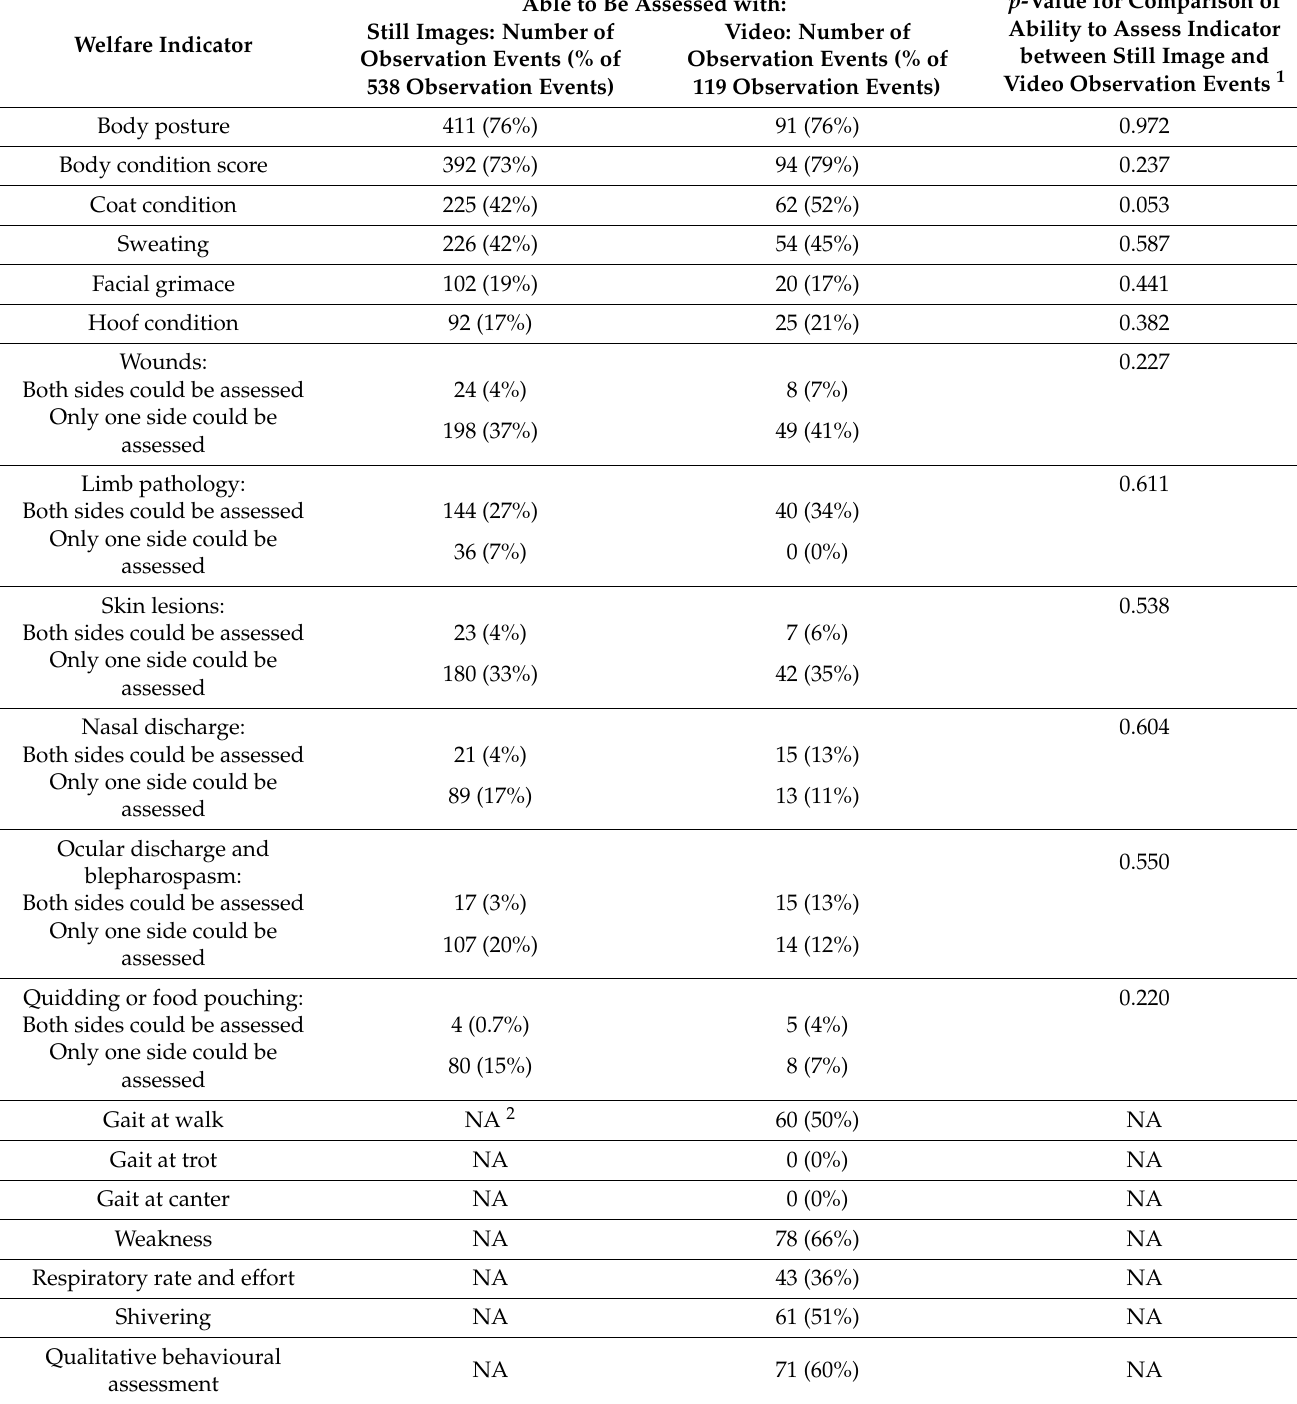
Table 7. Welfare indicators assessed with camera trap still images and